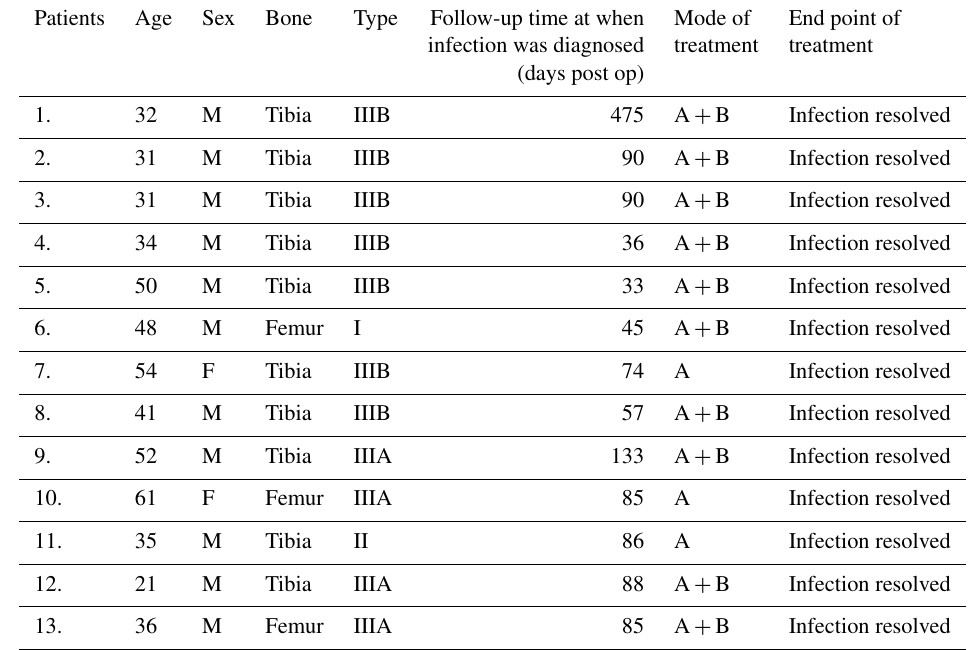
Table 3. Follow-up of infected cases ( n =